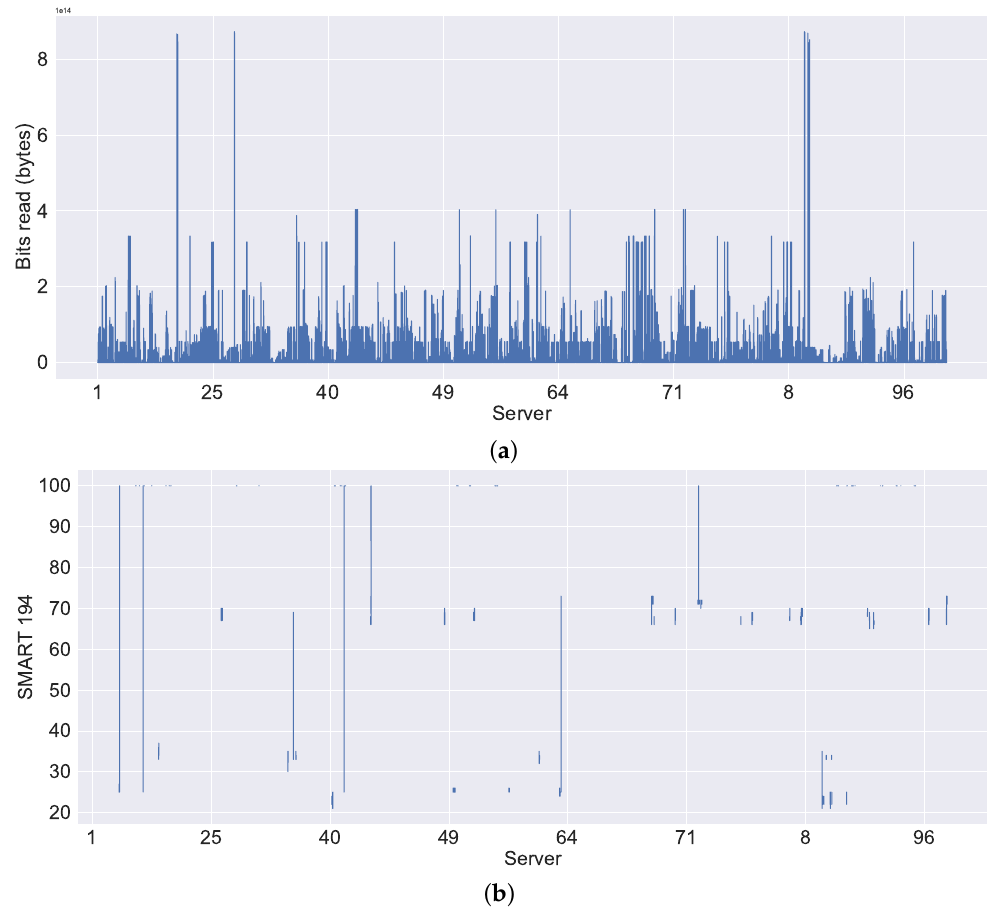
Figure 9. Visualisation of bits read and SMART 194 based on the server. ( a ) Visualisation of the data written out from the disk (bits read); ( b ) visualisation of SMART